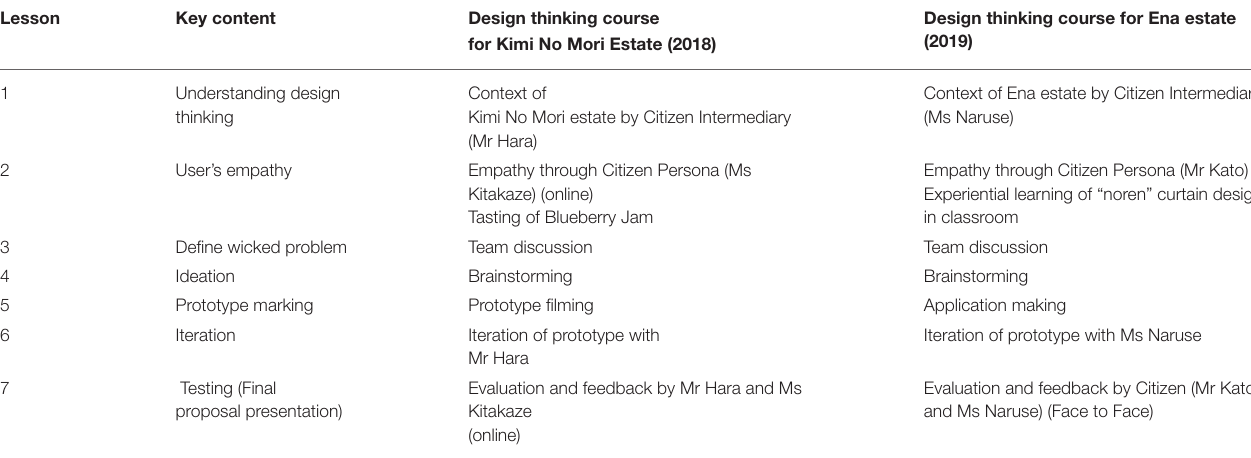
TABLE 3 | Process of citizen engagement to create solutions. Lesson